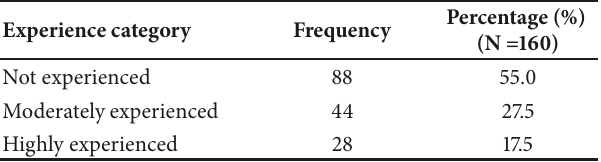
Table 8: Experience of midwives in neonatal